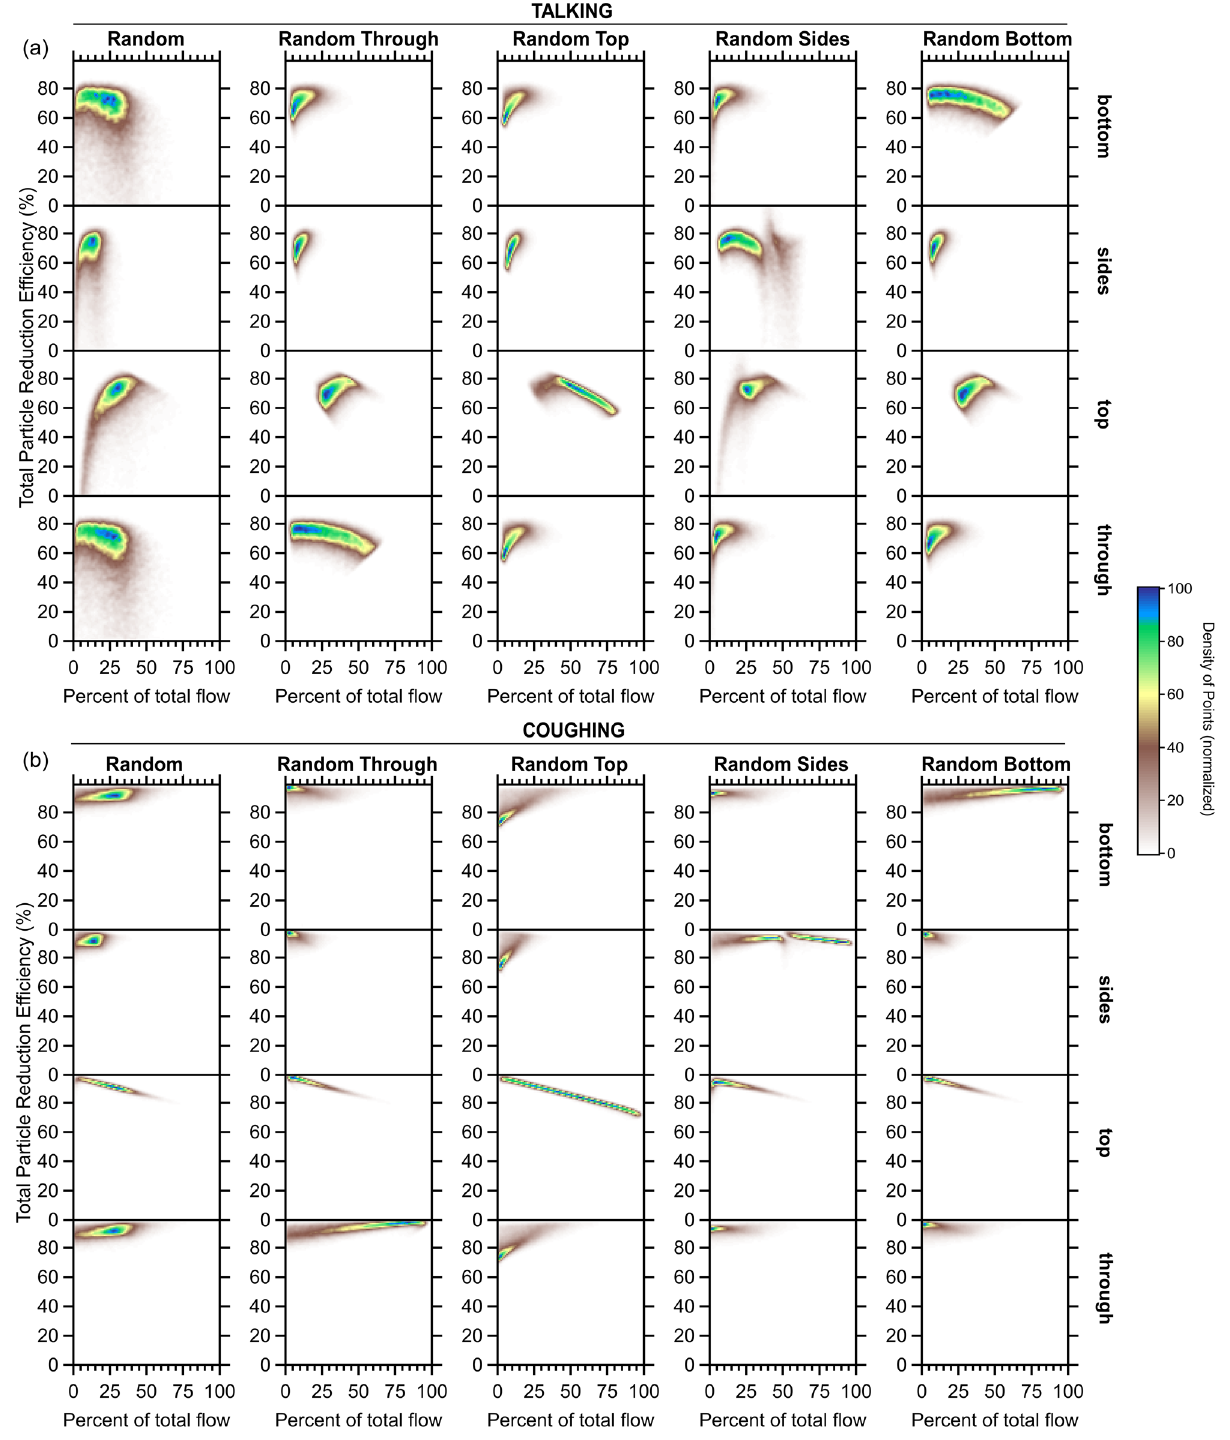
Figure 5. Two dimensional histograms of the calculated total particle reduction efficiency for the mask versus the percent of the total flow that passes through the mask, escapes out the top, escapes out the sides, or escapes out the bottom for simulations with the five differing model constraints on the flows for ( a ) talking or ( b ) coughing. Colors indicate the density of individual results from the simulation iterations, from brown (low density) to blue (high density). The labels at the graph tops (e.g., “Random”) indicate the particular model constraint while the labels on the right (e.g., “bottom”) refer to the direction of the airflow. For example, the graph for the [Random, through] pair shows the probability that a particular particle reduction efficiency is achieved for air having passed through the mask when the flowrates in each direction are randomly